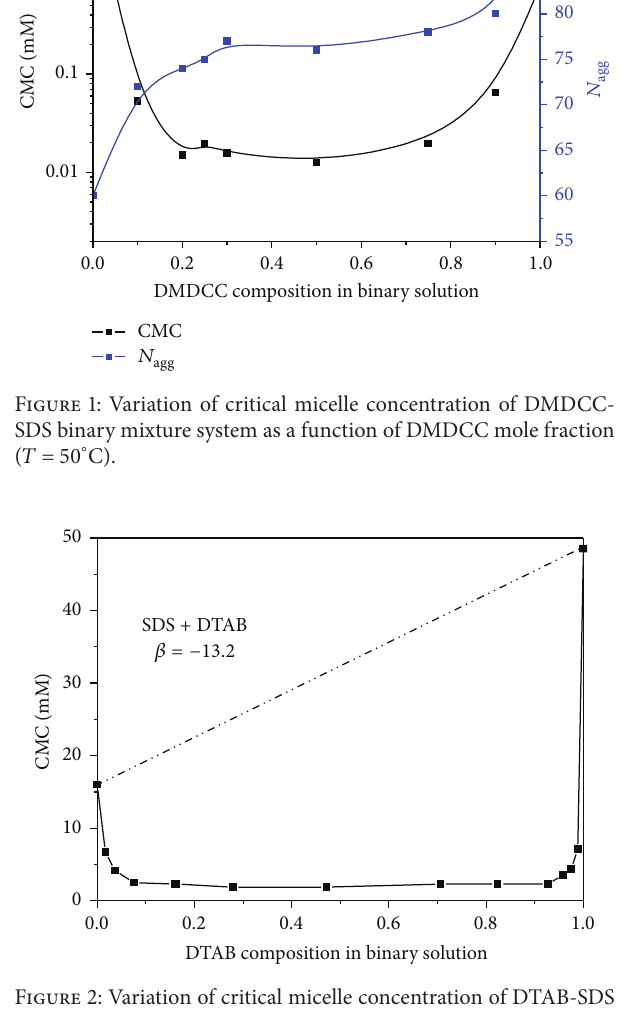
Figure 2: Variation of critical micelle concentration of DTAB-SDS binary mixture system as a function of DTAB mole fraction [22], reproduced from [22], with permission from John Wiley &